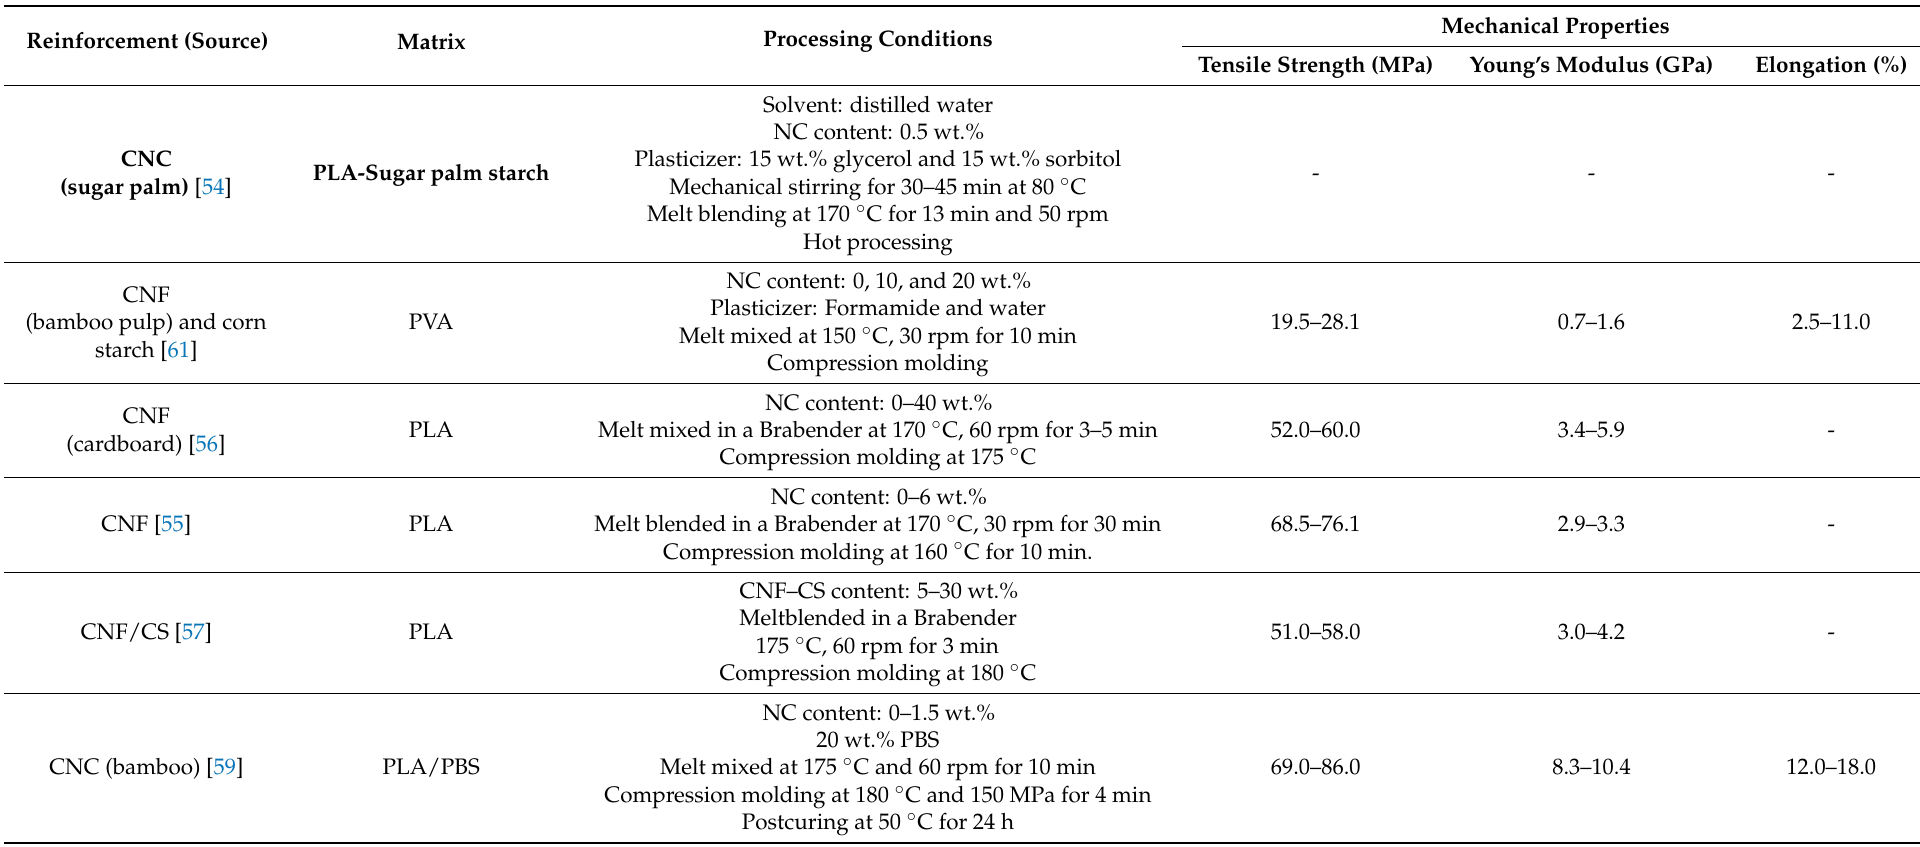
Table 2. Melt-processing conditions of nanocellulose biobased